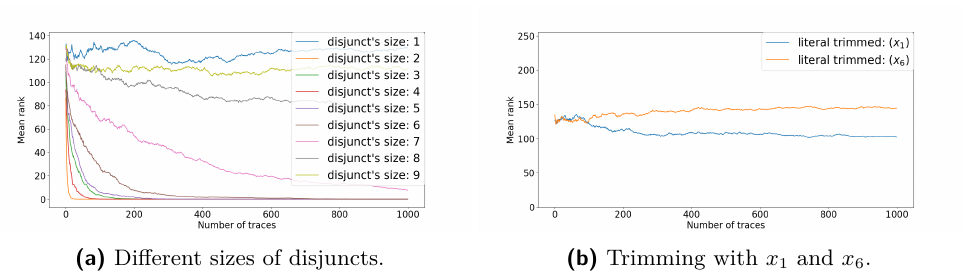
Figure 4: Guessing entropy of TTSCA small for simulated data with masking order 1.